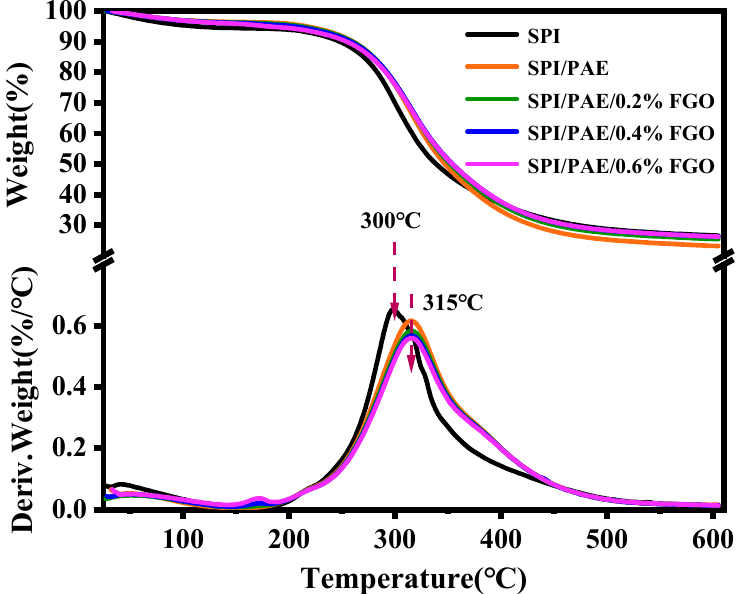
Figure 3. Thermal degradation curves of cured adhesives.